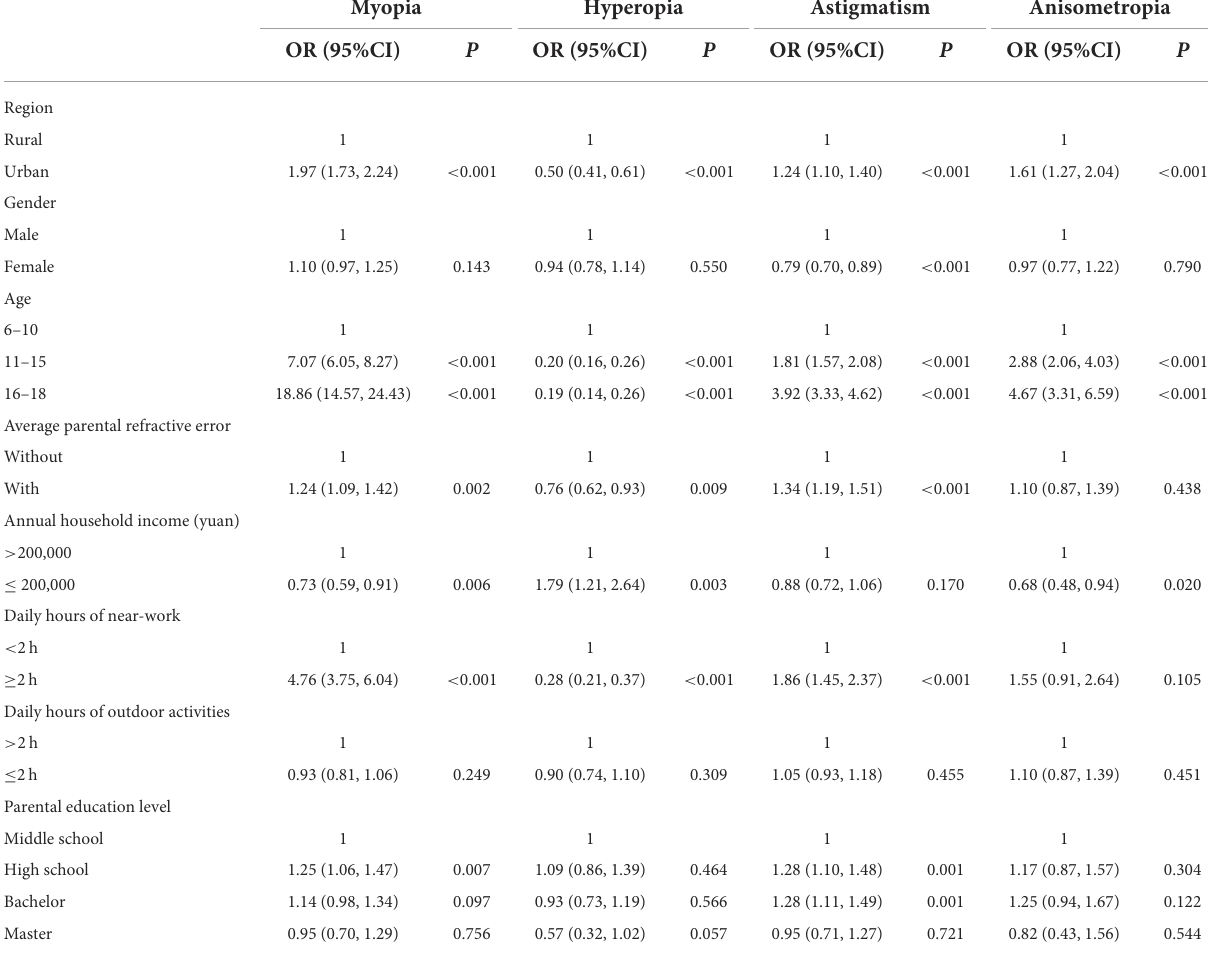
TABLE 3 Bivariate regression results for both the urban and rural participants.